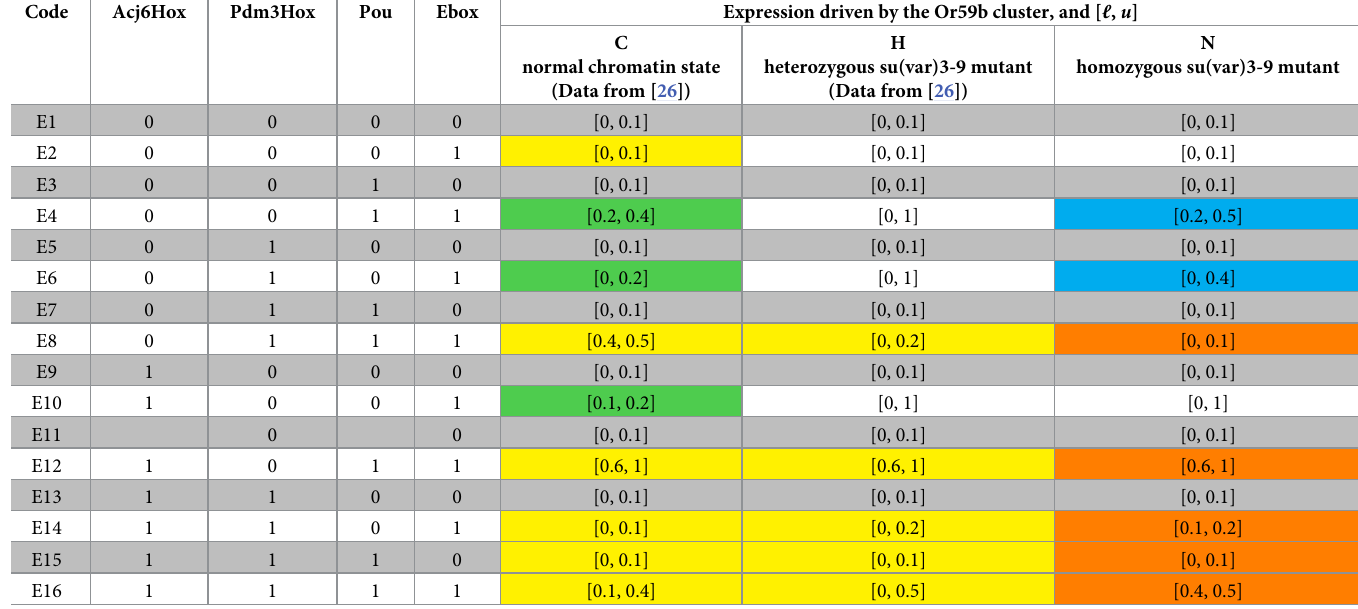
Table 1. Truth table of the expression patterns of the Or59b cluster experiments. In the four left columns the mutation table for the cluster motifs Acj6Hox, Pdm3Hox, Pou and Ebox is shown: 0 corresponds to mutated motif and 1 to unaltered motif. The 3 rightmost columns represent the expression driven by the Or59b cluster in Or59b receptors, in our model identified with P Or 59 b ð R (cid:0) TATAbox Þ . Values are between 0 (total loss) and 1 (very strong expression), see also Fig 1(B) and Table A of S1 Text. binding The 3 columns correspond to chromatin in its normal state (“closed”, column C), heterozygous mutation of su(var)3-9 (“open”, column H) and homozygous mutation of su(var)3-9 (“more open”, column N). Yellow cells represent configurations which have beed directly experimented in [26], green cells are configurations tested in an indi- rect way in [26], orange and blue cells are novel direct and indirect experiments. Gray cells correspond to experiments with mutated Ebox, which can all be marked as total loss. When a direct/indirect experiment is missing the cell is left white. The ranges [ ℓ , u ] = [upper bound, lower bound] are given according to our quantification of the GFP reporter fused to the TATA box. More details of this quantification are given in Table A of S1 Text. For E8, E12, E14 and E16, GFP expression on selected flies is shown in Fig 5(A)–5(C), and in Fig 1(C). For missing experiments a maximal range is chosen, i.e., [ ℓ , u ] = [0, 1] (except for E2 which always leads to loss of